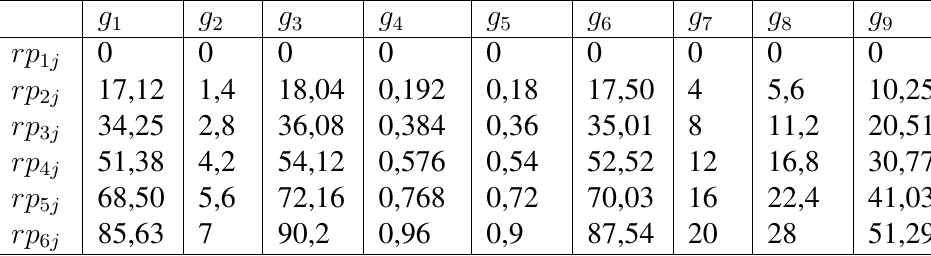
Table 3: Reference profiles rp